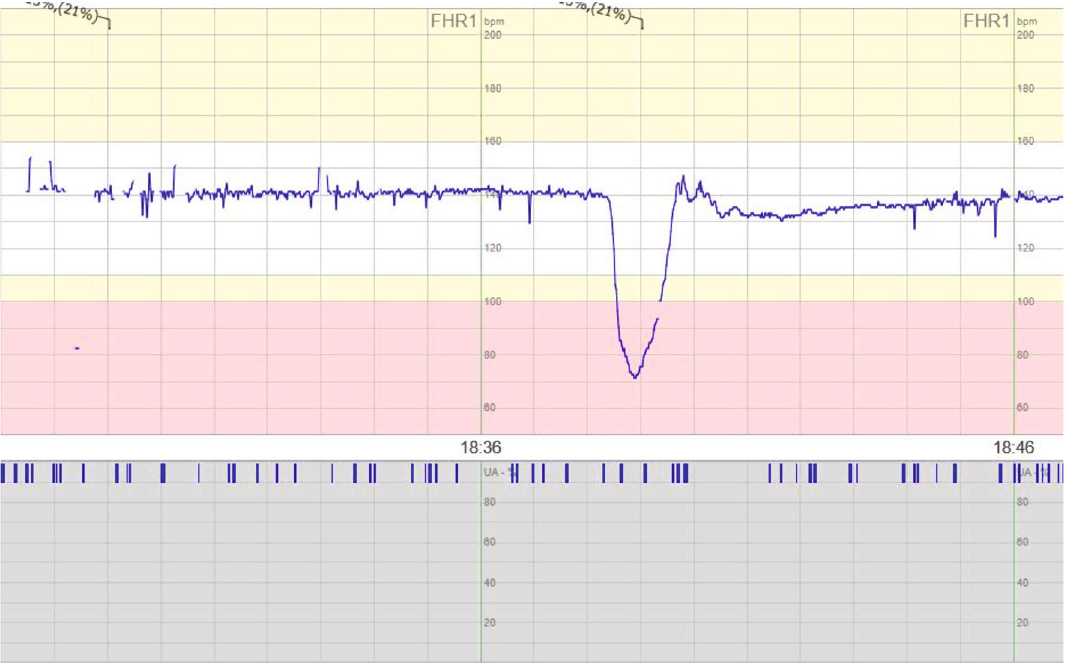
Figure 4: Patient 4 CTG at admittance to the hospital.